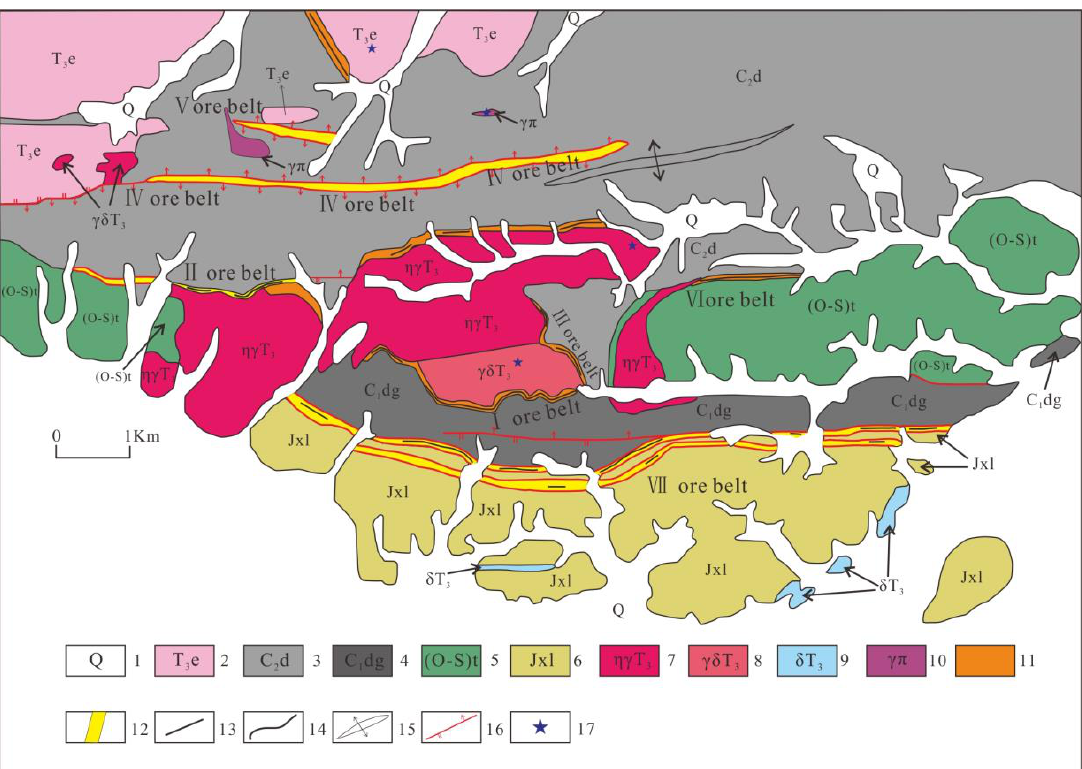
Figure 2. Geological and mineral resources map of the Hutouya deposit (modified after [24]). (1)